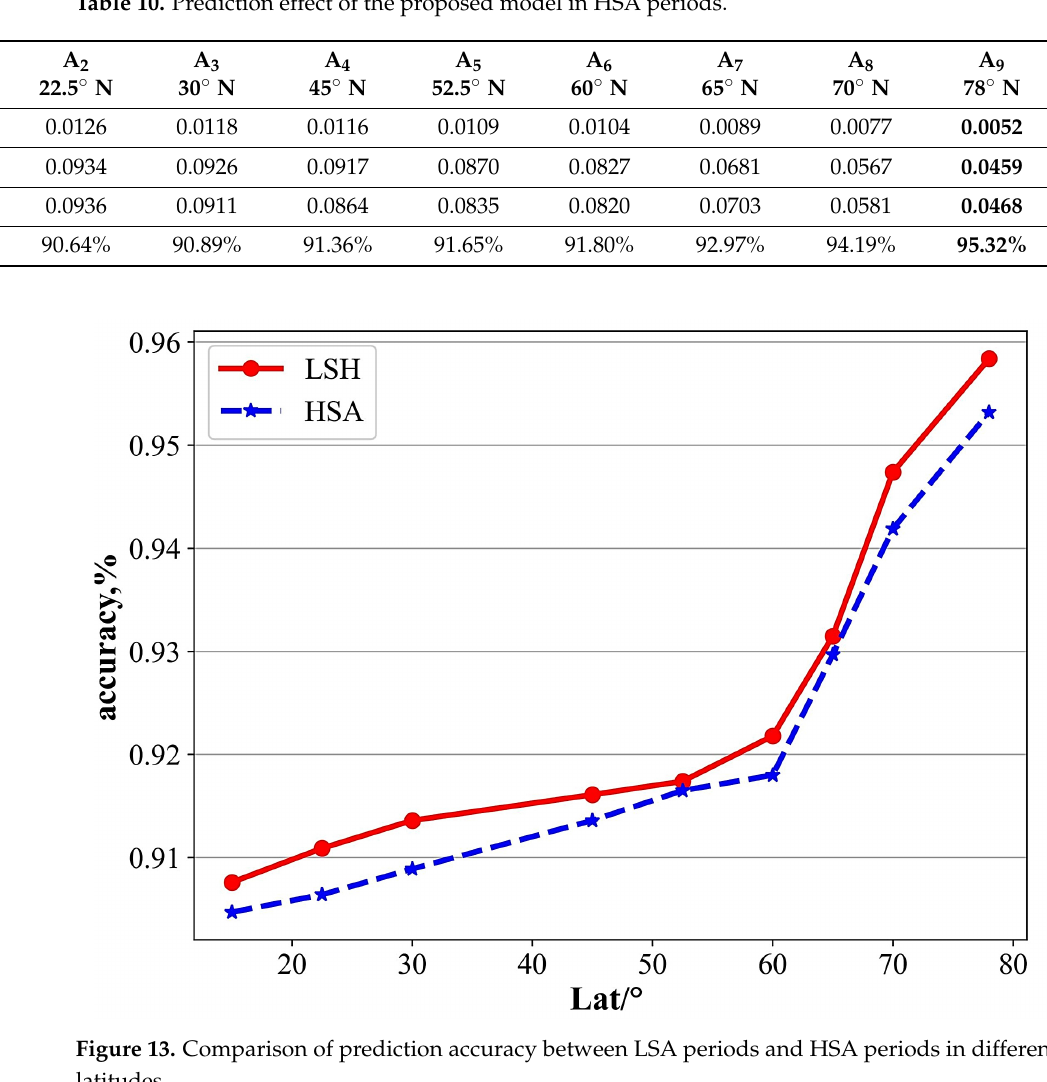
Table 10. Prediction effect of the proposed model in HSA periods.